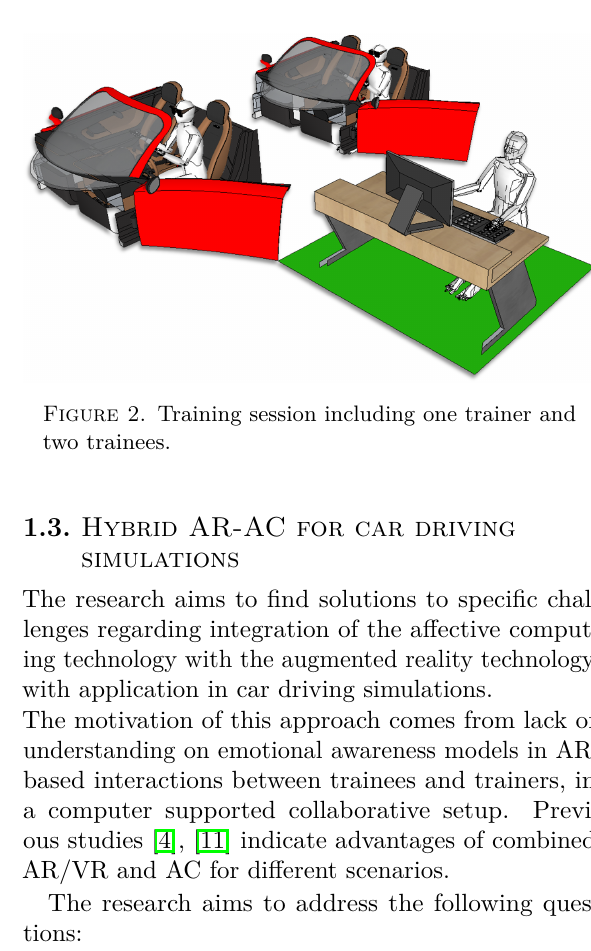
Figure 1. AR trainee using the car driving simulator